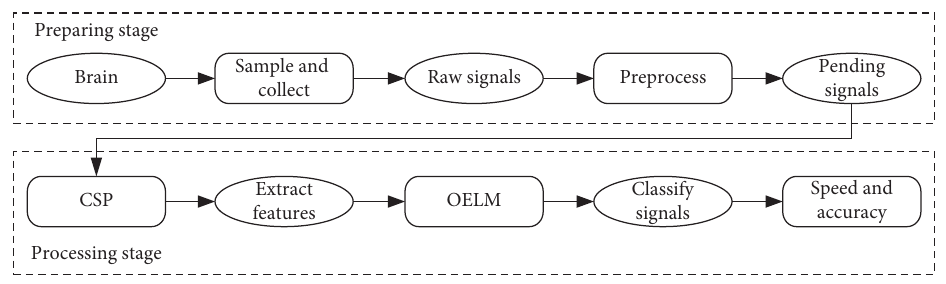
Figure 2: Detailed block scheme of CSP and OELM.